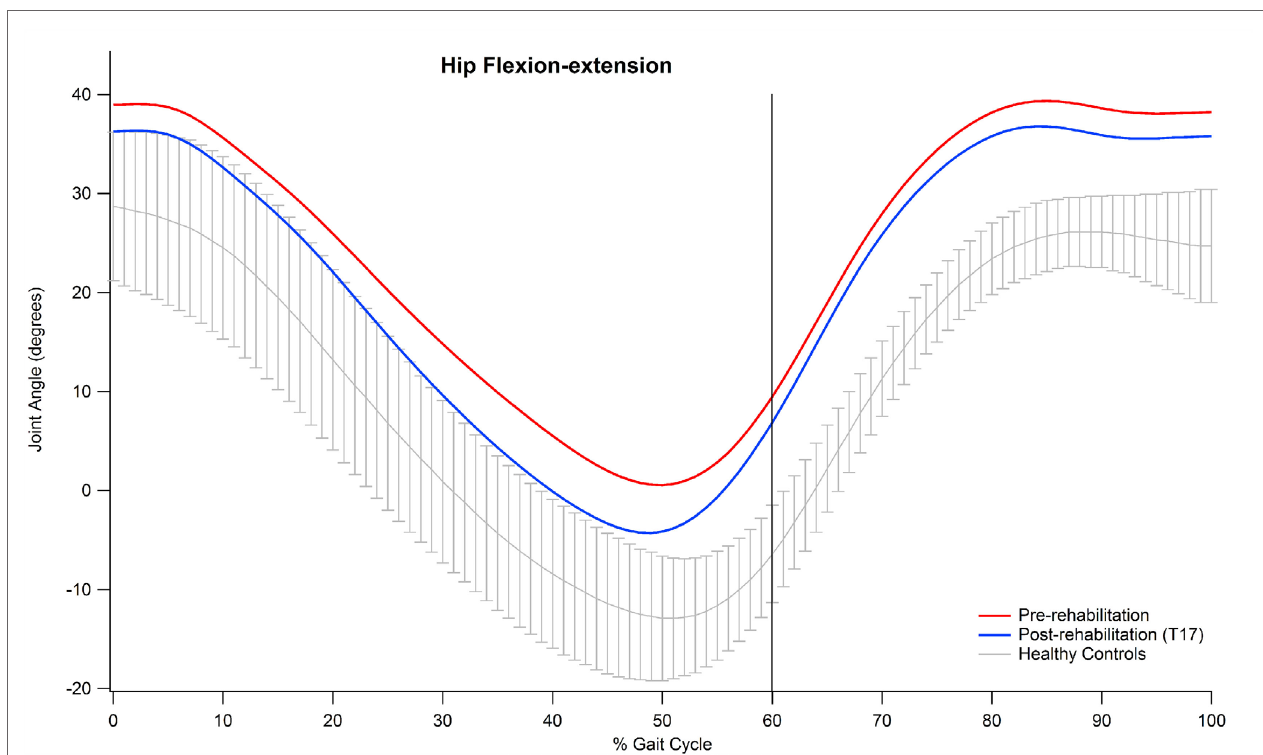
FigUre 3 | Mean value of hip flexion–extension angle of participants pre and post-rehabilitation (T17) during gait